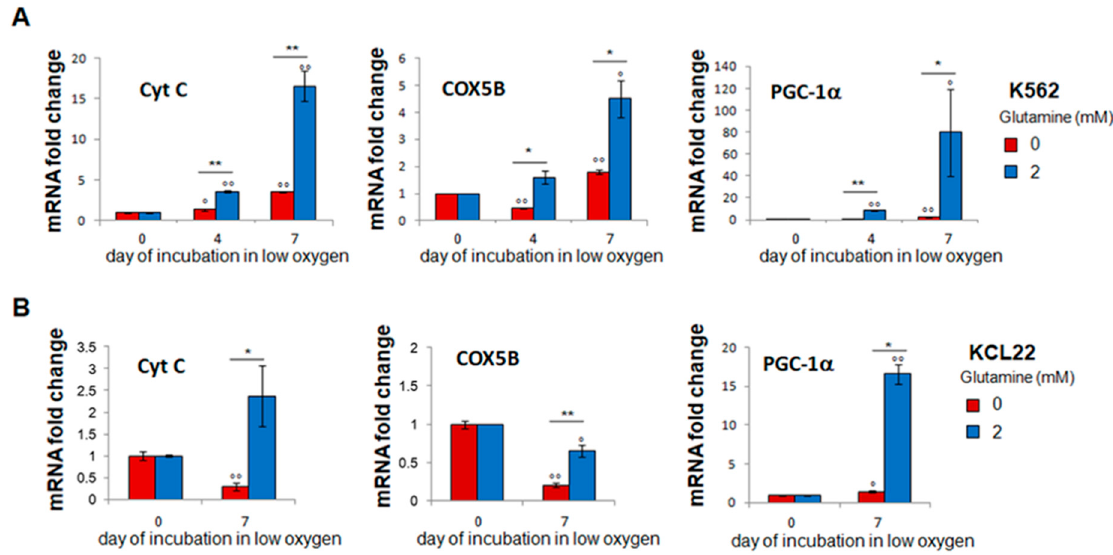
Figure 6. Glutamine enhances the expression of markers of mitochondrial respiration and biogenesis. K562 ( A ) or KCL22 ( B ) cells were seeded at 3 × 10 5 cells/mL and incubated in atmosphere at 0.2% O 2 for the indicated times in the absence (0) or the presence (2) of 2 mM glutamine from time 0 of incubation. The expression of cytochrome C (Cyt C), cytochrome-oxidase-5B (COX5B) and PGC-1a mRNA was measured using quantitative real-time PCR. Values are mean ± S.D. of data obtained from 3 independent experiments; ° p < 0.05, °° p < 0.01 vs. t0; 0 vs. 2 mM glutamine: * p < 0.05, ** p < 0.01.